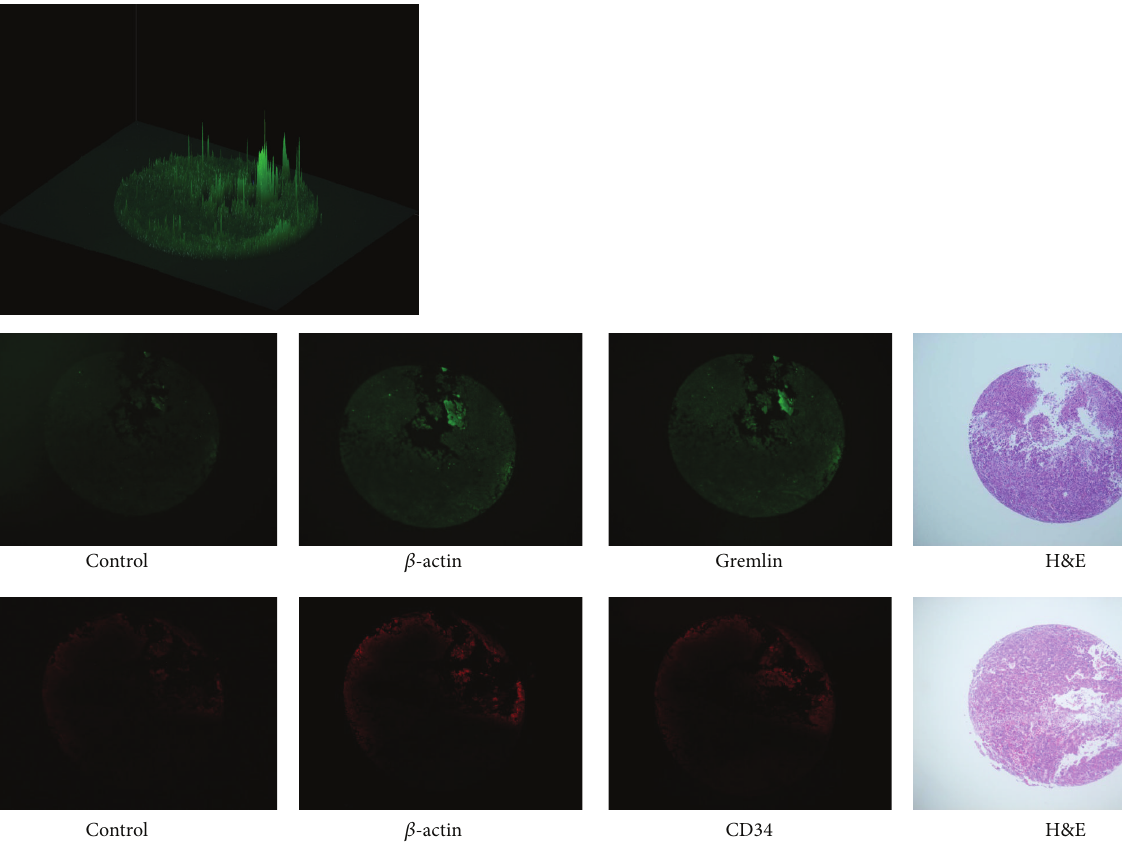
Figure 3: Brightness was quantified by image analysis software (ImagePro-Plusver. 7.0) was measured (upper left). Tissuemicroarray analysis of 60 cases. 𝛽 -actin was used as a positive control and normal rabbit IgG as a negative control (Gremlin, FITC; CD34, PI).